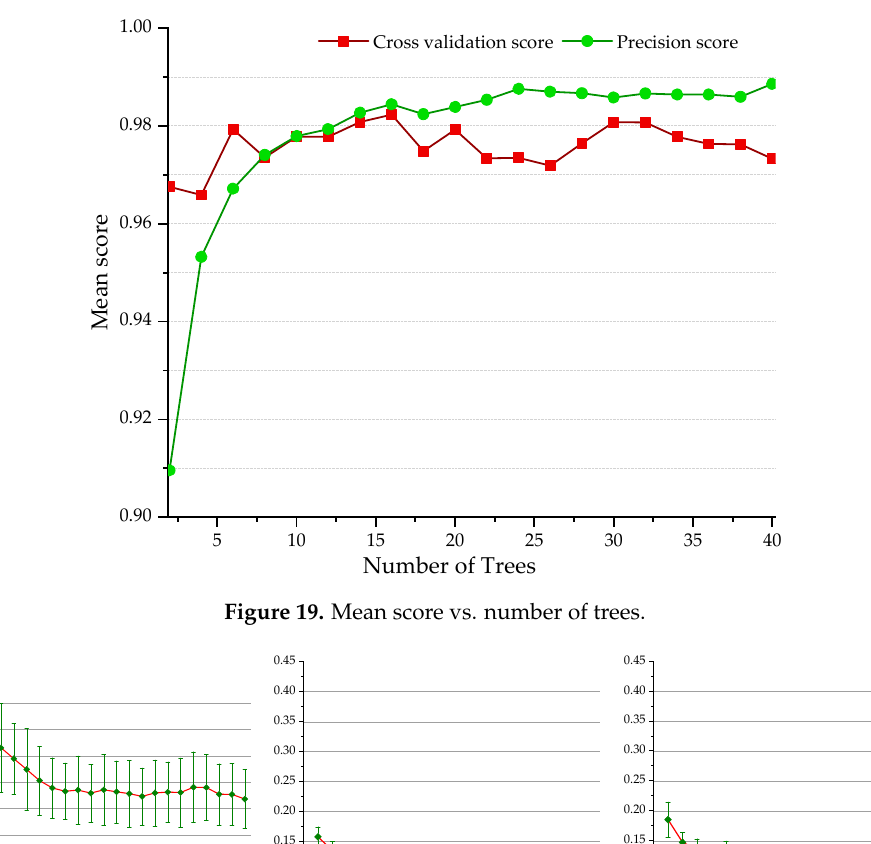
Figure 20. Mean and standard deviation of positioning errors vs. number of trees by: ( a ) whole floor, ( b ) center area, and ( c ) edge area.